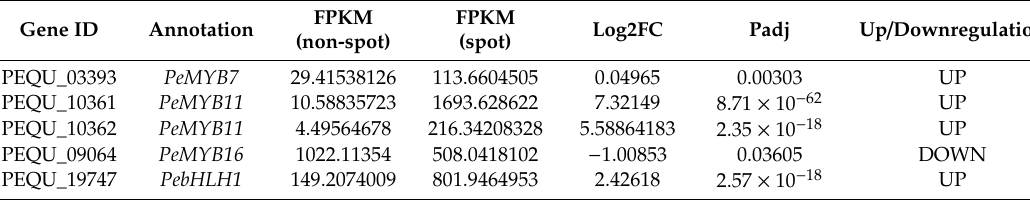
Table 2. Putative MBW genes identified from di ff erentially expressed genes (DEGs).